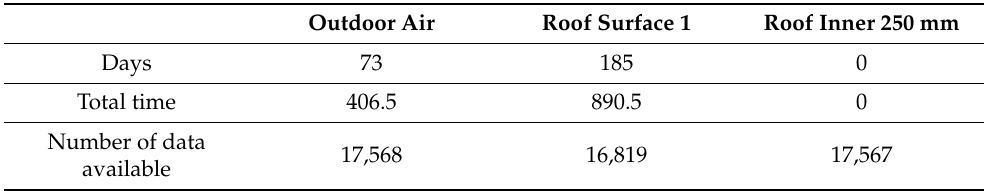
Table 2. The number of days and total time that the relative humidity reached 100% per year are shown for the outdoor air, thatched roof surface, and 250 mm inside the thatched roof. For the thatched roof surfaces and inside the roof, there were times when relative humidity data were not available. The number of days was calculated by counting the days when the relative humidity reached 100%, even temporarily. Since the measurement interval was 30 min, the total time (hours) was calculated as the number of data points at which the relative humidity reached 100% multiplied by 30